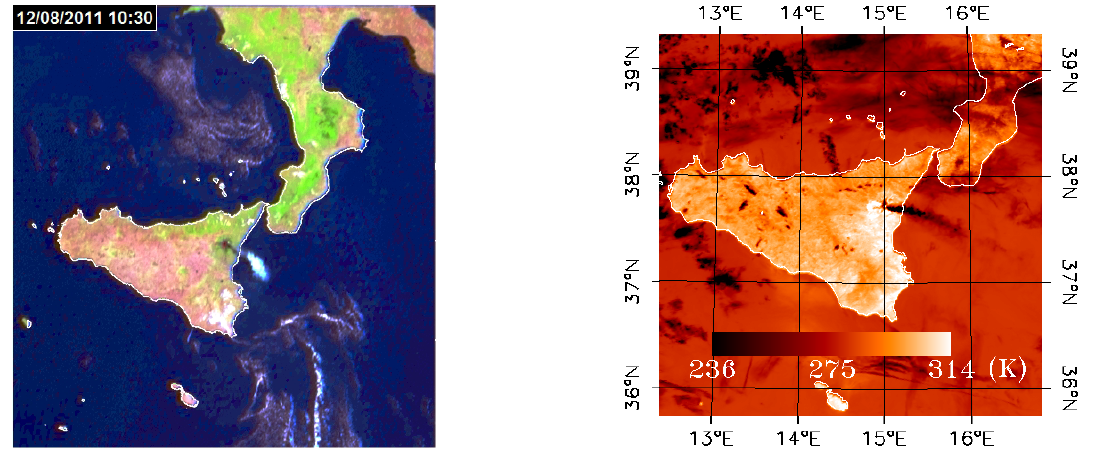
Figure 3. SEVIRI image of 12/08/2011 and MODIS-Terra brightness temperature map at 11 µm used to estimate the plume column height of 12/04/2013 (12:00 UTC).